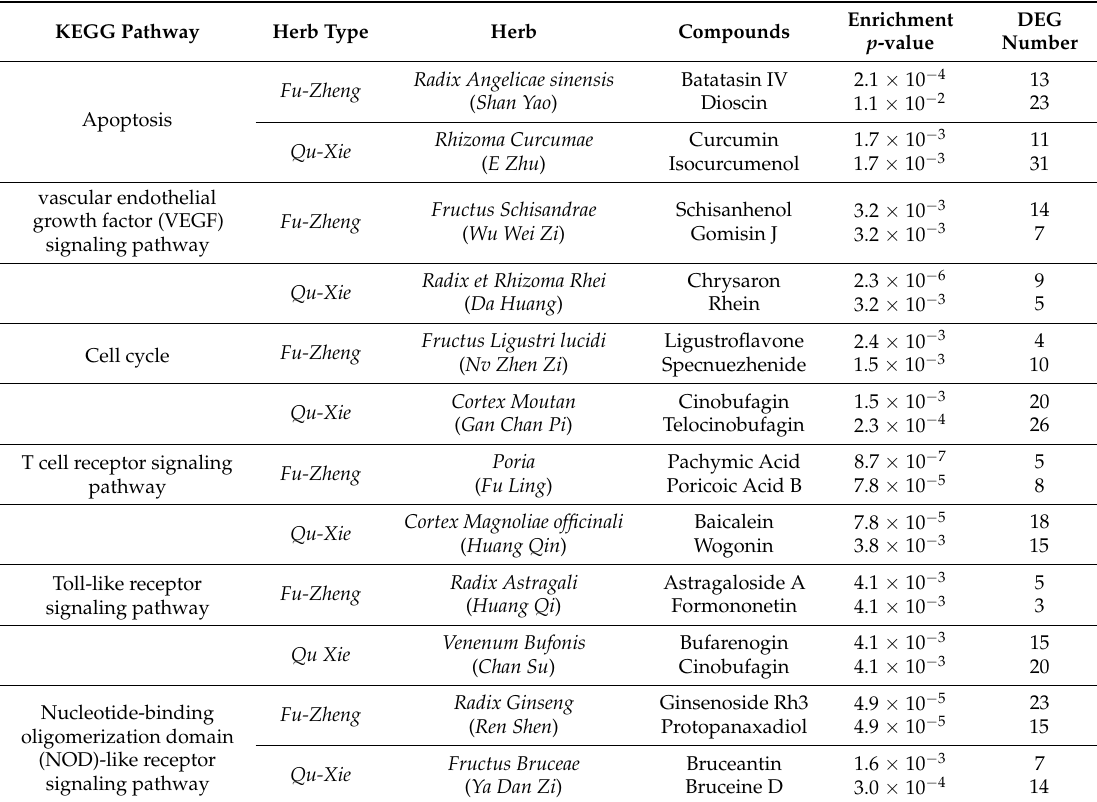
Table 1. Several KEGG pathways predicted to be regulated by compounds from health-strengthening and pathogen-eliminating herbs using target enrichment and the HTS 2